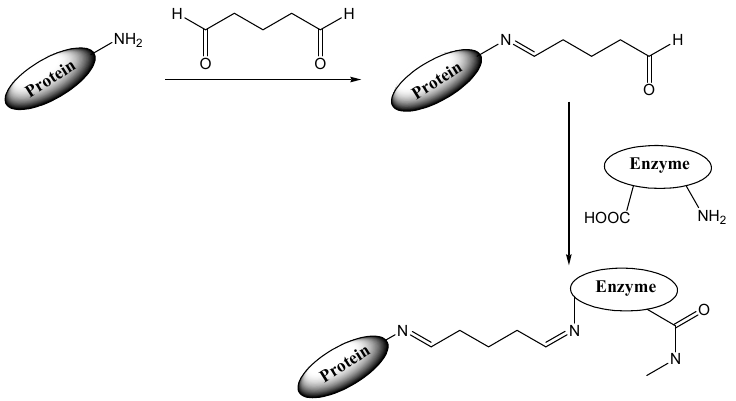
Figure 14. Immobilization of enzymes following glutaraldehyde crosslinking mechanism.